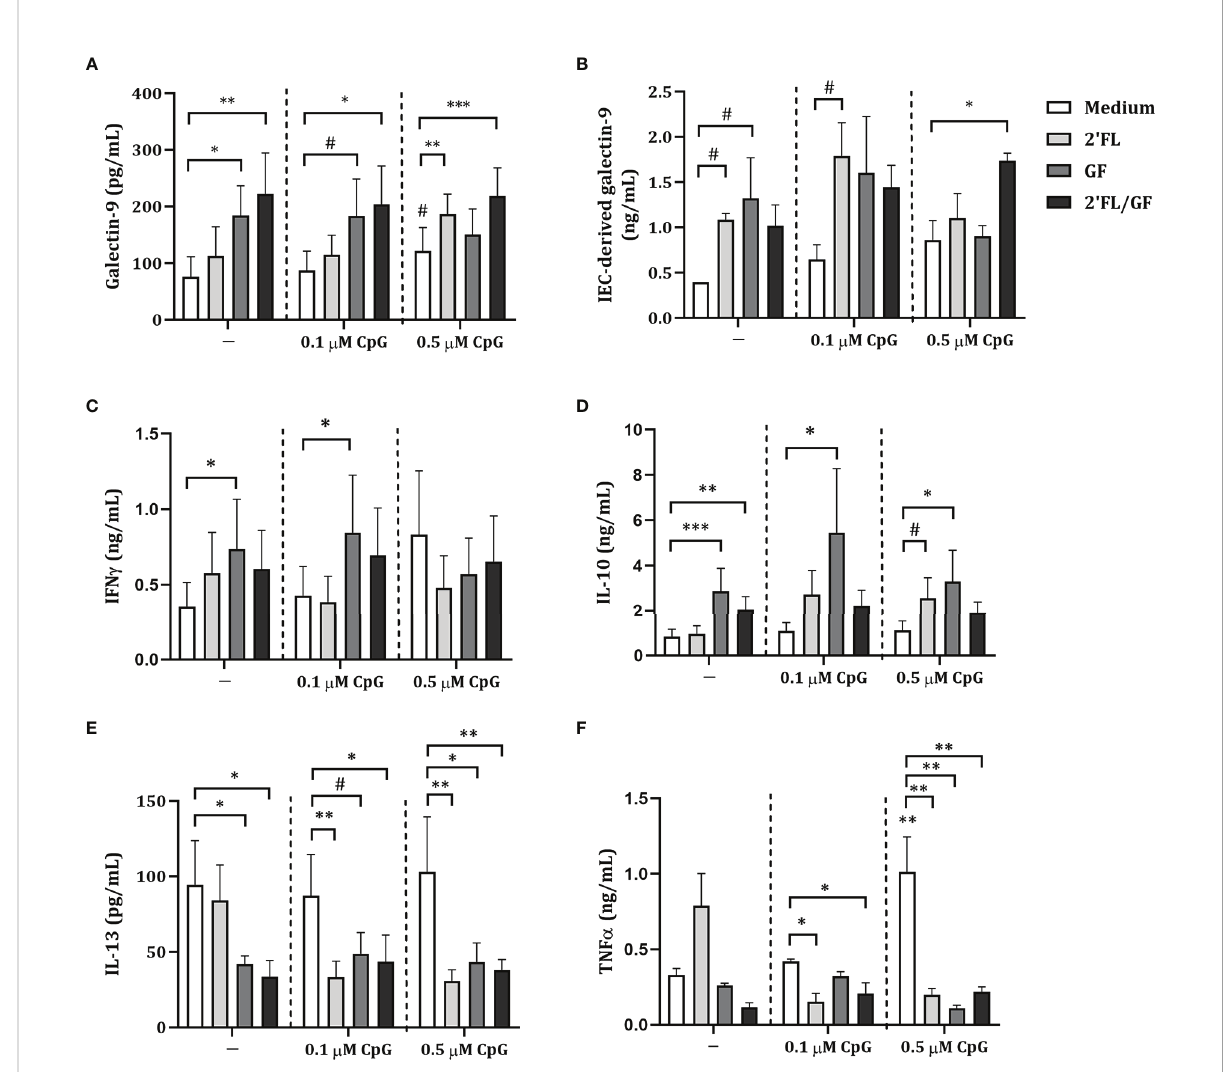
FIGURE 2 Cytokine and galectin-9 secretion in FHs 74 Int/PBMC co-culture model after exposure to non-digestible oligosaccharides and CpG. FHs 74 Int IEC were stimulated with 2 ’ FL, GF or 1:1 mixture of 2 ’ FL and GF (0.5% w/v ) in combination with CpG (0.1 or 0.5 µM) and basolaterally exposed to a CD3/CD28-activated PBMC for 24 h. After incubation, galectin-9 (A) , IFN g (C) , IL-10 (D) , IL-13 (E) and TNF a (F) were measured in the basolateral supernatant. Additionally, after IEC/PBMC co-culture, FHs 74 Int were washed and incubated in fresh medium for additional 24 h (total 48h; 24h IEC/PBMC co-culture and additional 24h IEC culture) after which IEC-derived galectin-9 (B) was measured in the basolateral supernatant. Data represent mean ± SEM of n = 3 independent PBMC donors. The conditions without CpG and with 0.1 or 0.5 µM CpG were analyzed separately as represented by the dotted line. Within this analysis, a comparison between the medium control and CpG alone was included (# p < 0.1, * p < 0.05, ** p < 0.01, *** p <